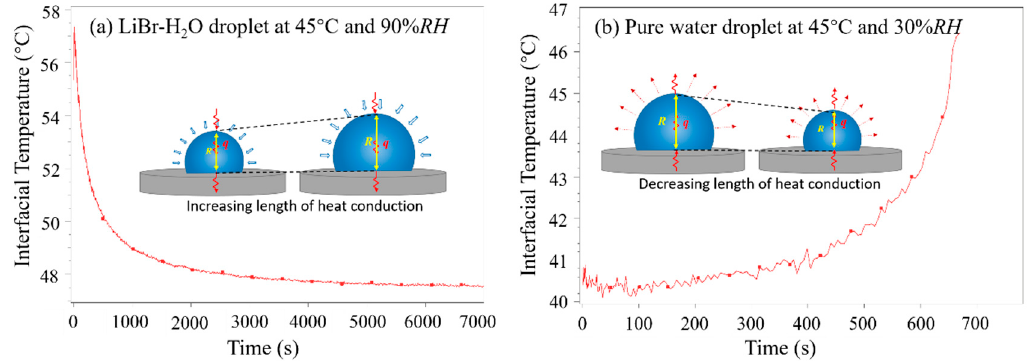
Figure 6. Variation of average interfacial temperature of ( a ) a LiBr-H 2 O droplets at 45 ◦ C and 90% RH , and ( b ) a pure water droplet at 45 ◦ C and 30% RH on PTFE substrates coated with FEP.